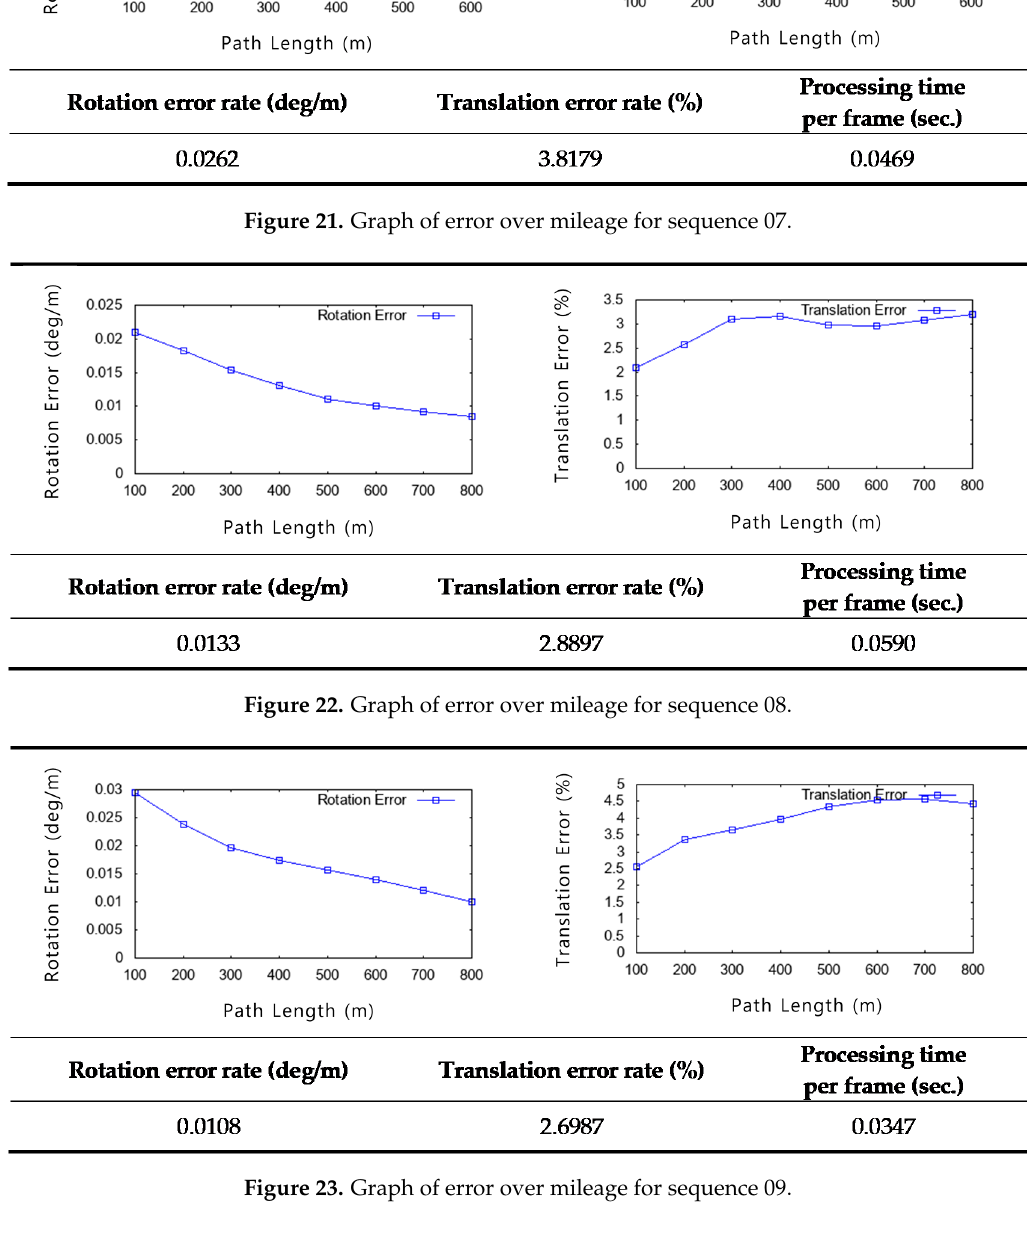
Figure 24. Graph of error over mileage for sequence 10. 4. Discussion Through the comparison of Figures 8 and 9, we could see that the features on the moving object were eliminated by the proposed optimization scheme. In order to confirm the effectiveness of the optimization, the experiment was performed with sequence 09. Through the comparison of Figures 10–12, the features on moving objects were eliminated, and the rotation error rate decreased by 8.9383 deg/m, while the translation error rate decreased by 0.0176%. Then, we experimented with three different zones with different numbers and degrees of curves. The rotation error rate was smaller than the translation error rate. Also, we observed that the error generally occurred in the curved road rather than the straight road. In Table 4, the average processing time per frame was 0.0313 s. For ten sequences provided by KITTI, the average rotation error was 0.0175 deg/m, translation error was 3.5520%, and the running time per frame was 0.0554 s. The rotation error tended to decrease with the moving distance, but the translation error tended to increase. Through all experiments shown, we confirmed that the proposed feature optimization scheme worked successfully and that real-time processing was possible. Our research is ongoing and the performance shown here needs further improvements, particularly compared to known optimal algorithms. For example, SOFT2 [4] achieved a rotation error of 0.014 deg/m, a translation error of 0.65%, and a processing time of 0.1 s/frame. Nevertheless, our results support our intention of using photogrammetric analysis as an alternative outlier removal method. We showed that the proposed photogrammetric processing could enable successful outlier removal and that real-time processing was feasible even with photogrammetric iterative estimations. It is notable that we adopted the concept of circular matching proposed in CFORB [8] and enhanced its performance by photogrammetric optimizations. CFORB achieved a rotation error of 0.0107 deg/m, a translation error of 3.73%, and a processing time of 0.9 s/frame [8].